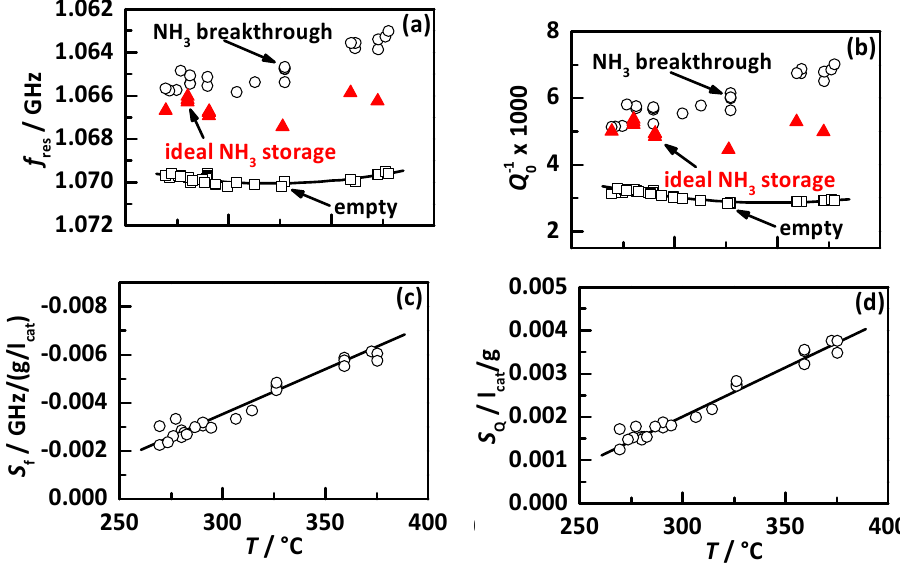
Figure 2. Results of Ref. [20] used for RF system calibration: the RF signals for different states in ( a ) for f res and ( b ) for Q 0–1 with the empty state (squares), the ideal NH 3 storage (red triangles) and the NH 3 loading as first breakthrough occurs (circles), and the determined sensitivities to NH 3 storage in ( c ) for f res and in ( d ) for Q 0–1 . The used calibration functions for the empty state and the NH 3 sensitivity for both RF parameters are displayed by black curves.